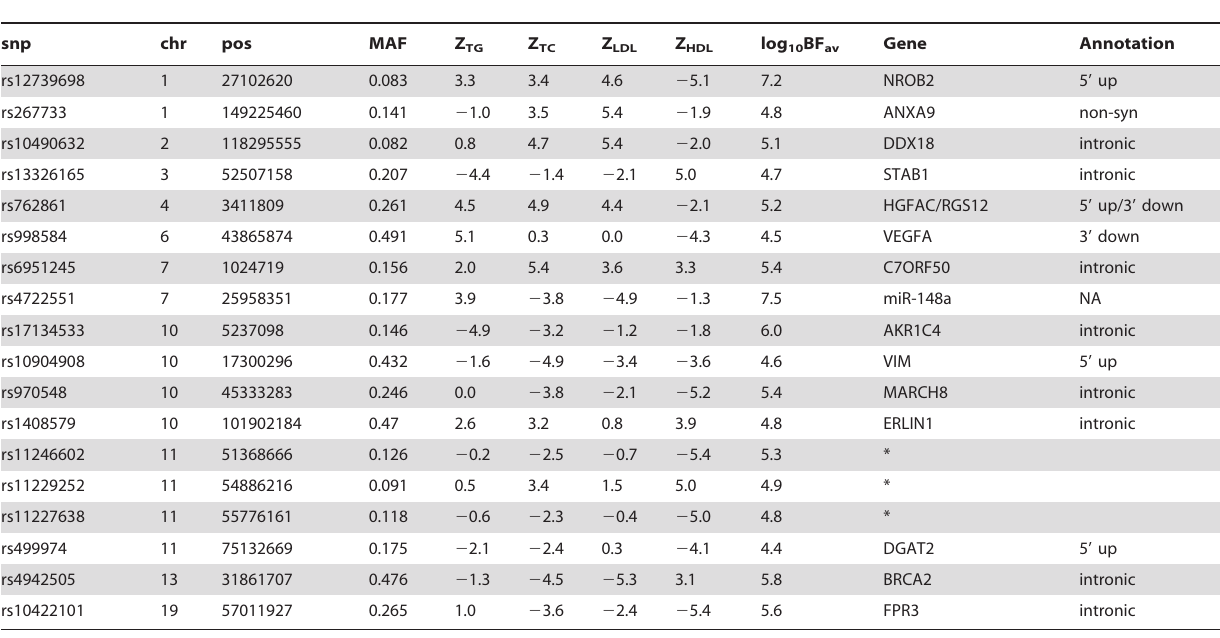
Table 2. Putative novel associations identified by multivariate analysis of the Global Lipids Data. snp